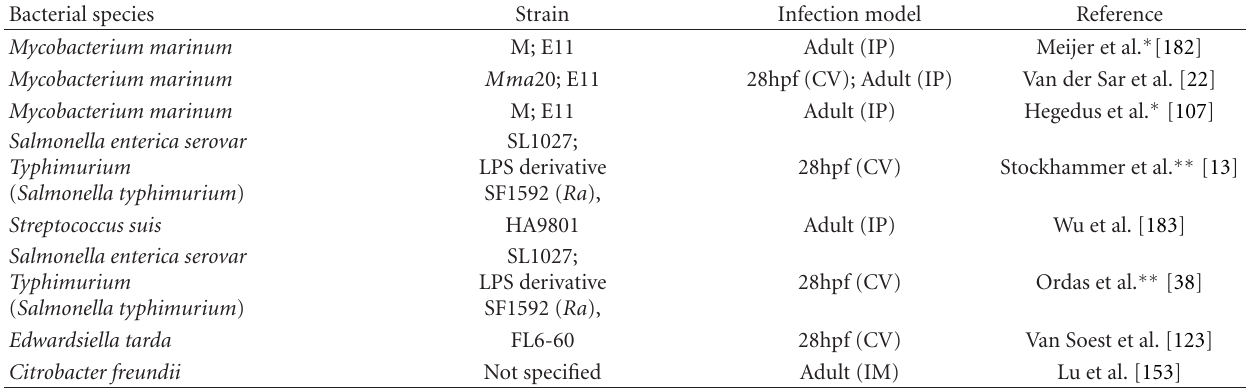
Table 1: Transcriptome profiling studies on infection models in adult and embryonic